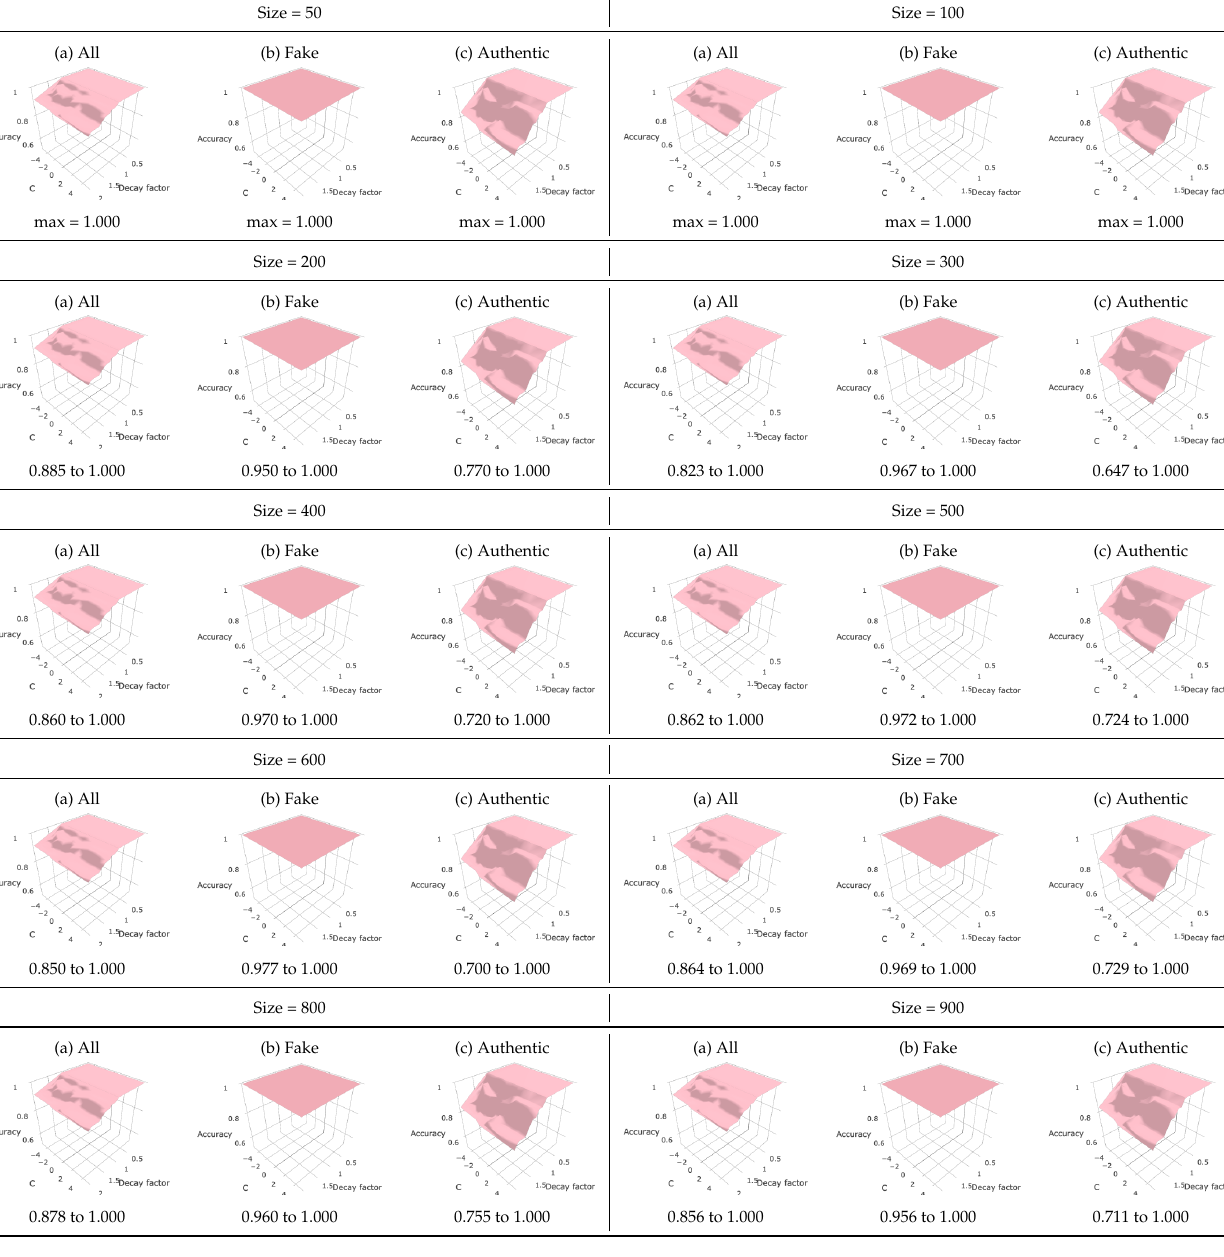
Figure 17. Cross validation scores for training datasets of size = 50, 100, 200, 300, 400, 500, 600, 700, 800 and